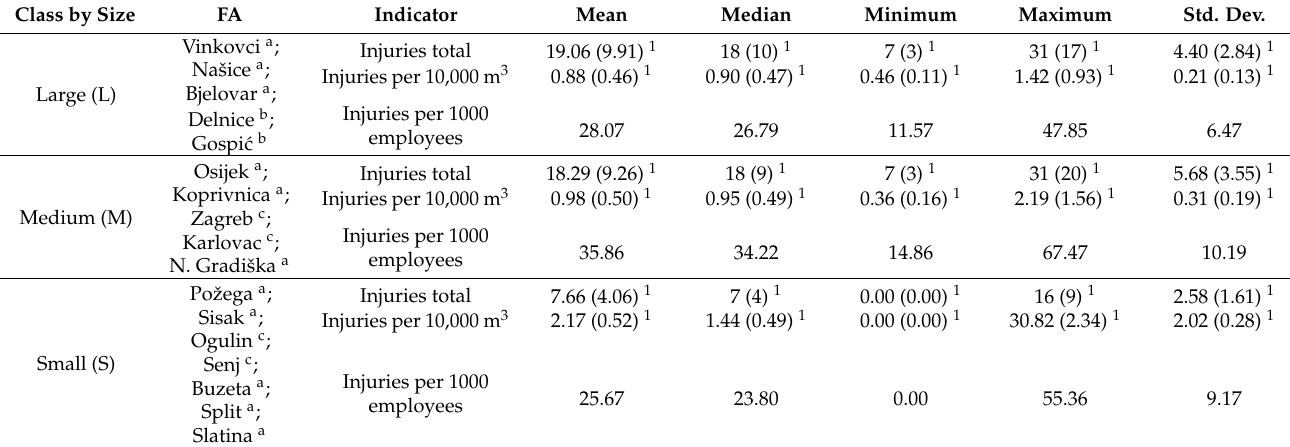
Table 3. Descriptive statistics of selected safety indicators for organizational units of the company CF Ltd. by size class. Class by Size FA Indicator